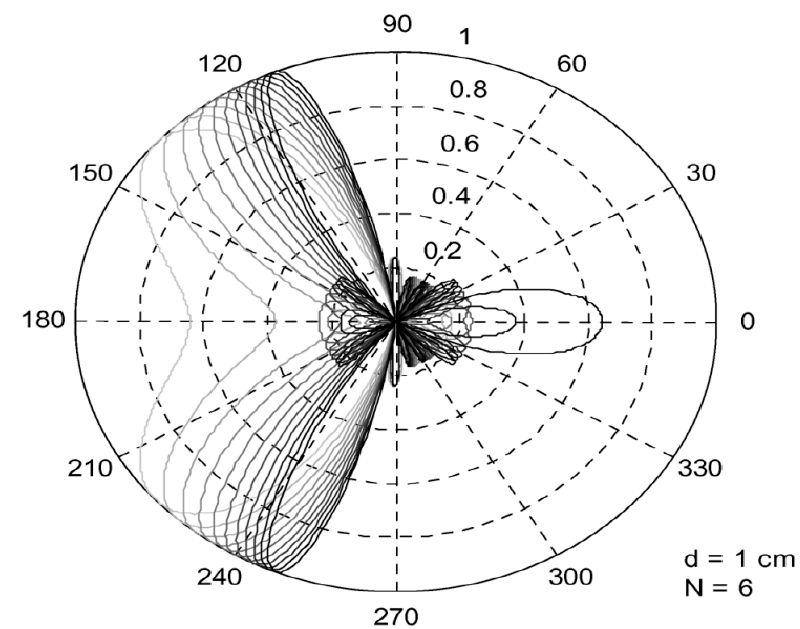
Figure 6. Beam squint effect for a phased array antenna using electrical phase shifters operating at frequencies in the range of 10–20 GHz [39].